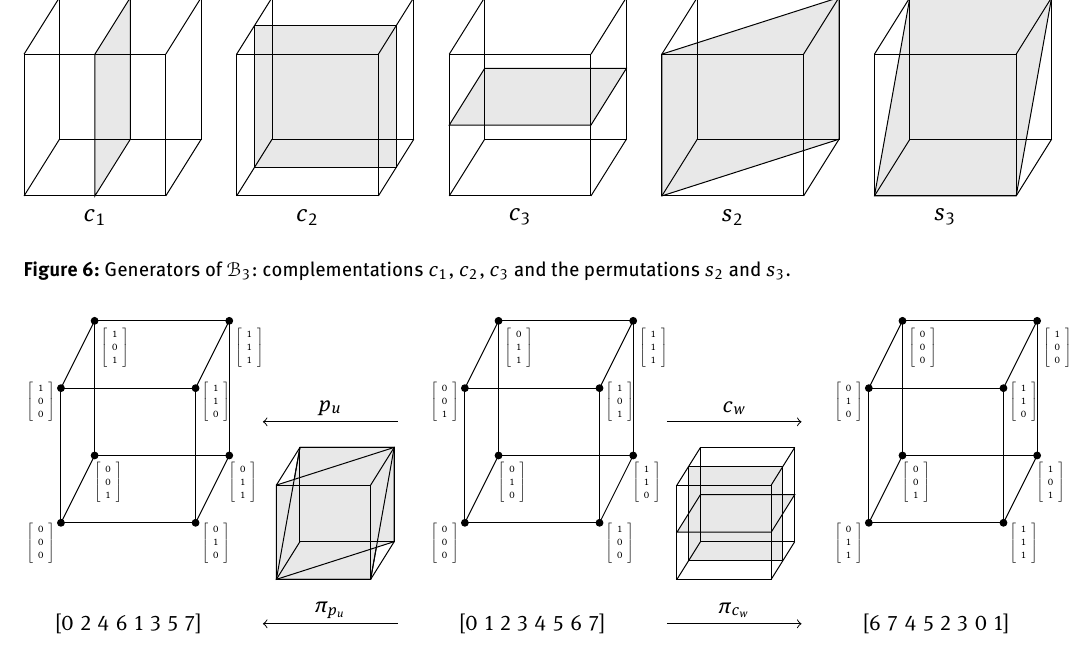
Figure 7: A complementation c w , a permutation p u , and their induced permutations in S 8 .